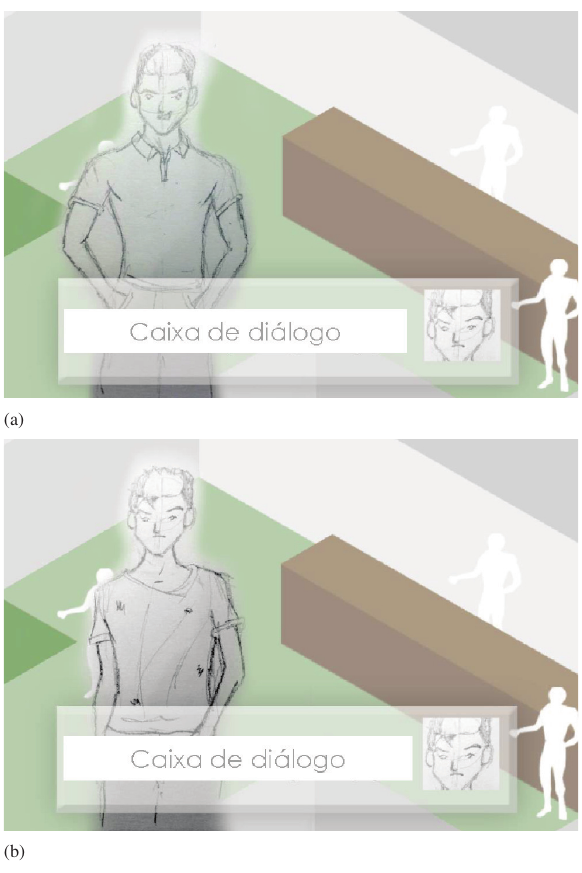
Fig. 11. Graphically conveying changes to the physical condition of the main character in the game for chemically dependent patients. (a) Healthy character; (b) unhealthy character, poorly dressed, dirty, and wounded.